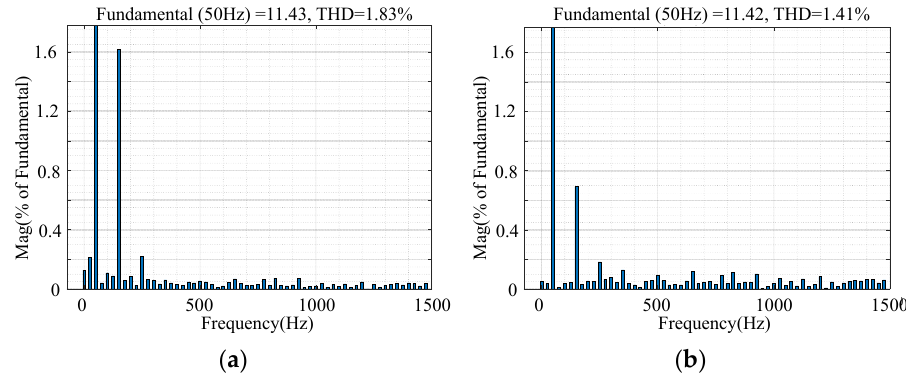
Figure 7. Harmonic spectrum of grid-connected current: ( a ) GISMC; ( b ) DRFNNISMC.